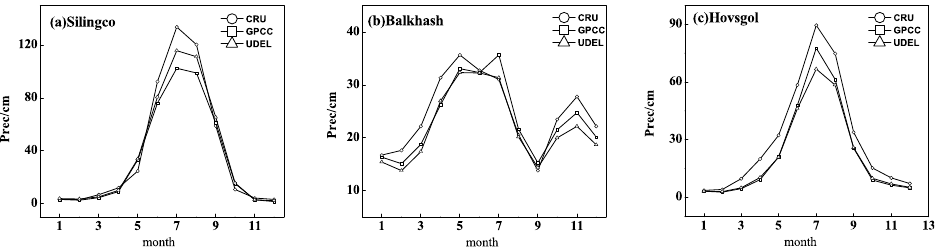
Figure 2. The seasonal cycle of precipitation from different gridded datasets over three lakes from three endorheic lake zones during the period of 1990–2016: ( a ) Lake Silingco, selected as the example for the Tibetan Plateau (TP), ( b ) Lake Balkhash, from the Central Asia (CA), and ( c ) Lake Hovsgol, from the Mongolian Plateau (MP).